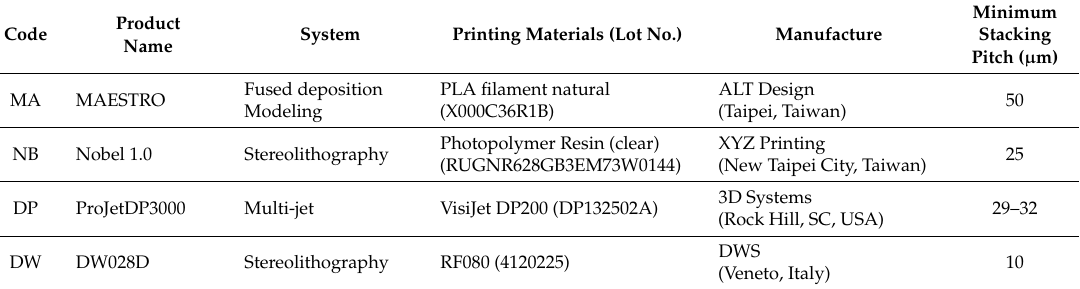
Figure 1. Dimensions of the cylindrical patterns of the model crowns. Table 1. The 3D printers and printing materials used in this study.